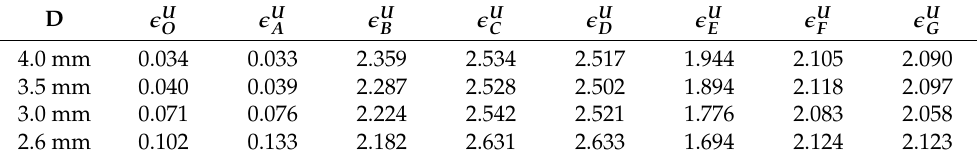
Table 5. Logarithmic strain at different positions of triaxial geogrid after longitudinal stretching.